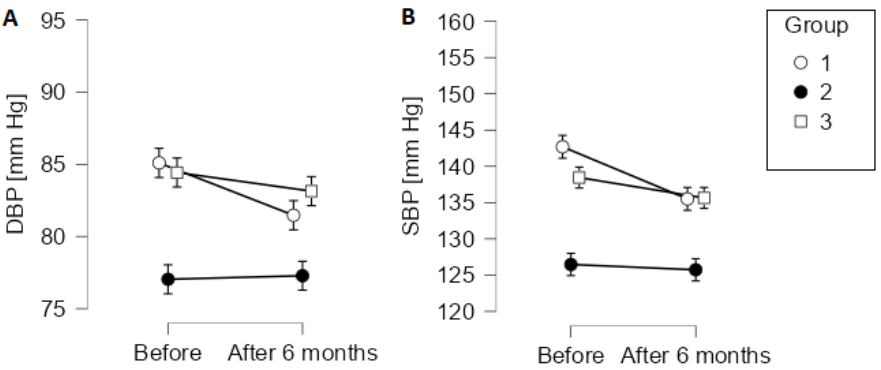
Figure 1. Change in diastolic ( A ) and systolic blood pressure ( B ) from baseline to 6 months after cardiac rehabilitation by group. Error bars show 95% confidence intervals. DBP, diastolic blood pressure; SBP, systolic blood pressure.